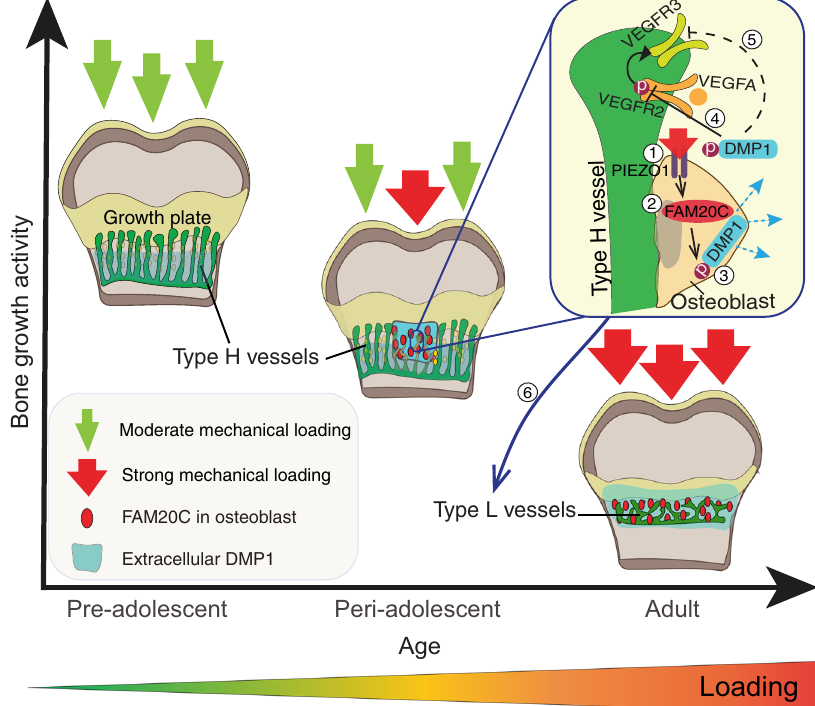
Fig. 7 Molecular mechanism transforming type H into type L vessels to limit adolescent bone growth activity. At the age of preadolescence, body weight- associated mechanical loading at the OF-GP border is only moderate, thus allowing the tip cells of type H vessels to invade the GP and promote bone elongation. During periadolescence, mechanical loading through increased body weight and/or muscle contractions triggers the mechanoreceptor PIEZO1 (1) to enhance the production of FAM20C kinase (2) in osteoblasts, which induces a burst in DMP1 secretion into extracellular matrix (3). Large amounts of extracellular DMP1 inhibit VEGF signalling in the OF by preventing the phosphorylation of VEGFR2 (4) and – presumably indirectly via reduced activation of VEFGR2 – the expression of VEGFR3 (5) on the tip cells of type H endothelium. Hence, highly-angiogenic type H vessels are transformed into quiescent type L vasculature to limit bone growth activity (6). In parallel, extracellular DMP1 leads to rapid matrix mineralisation and strengthening of long